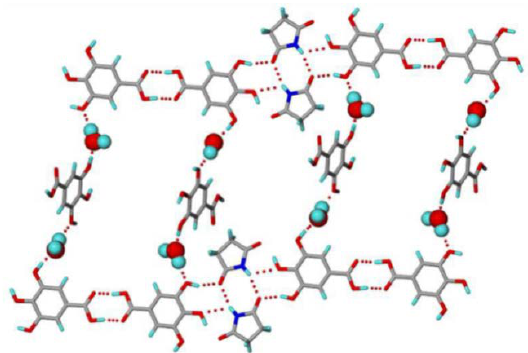
Figure 32. Staircase network in gallic acid-succinimide-water (1:1:1) cocrystal [Reprinted from [288] with permission. Copyright 2016 Royal Society of Chemistry].